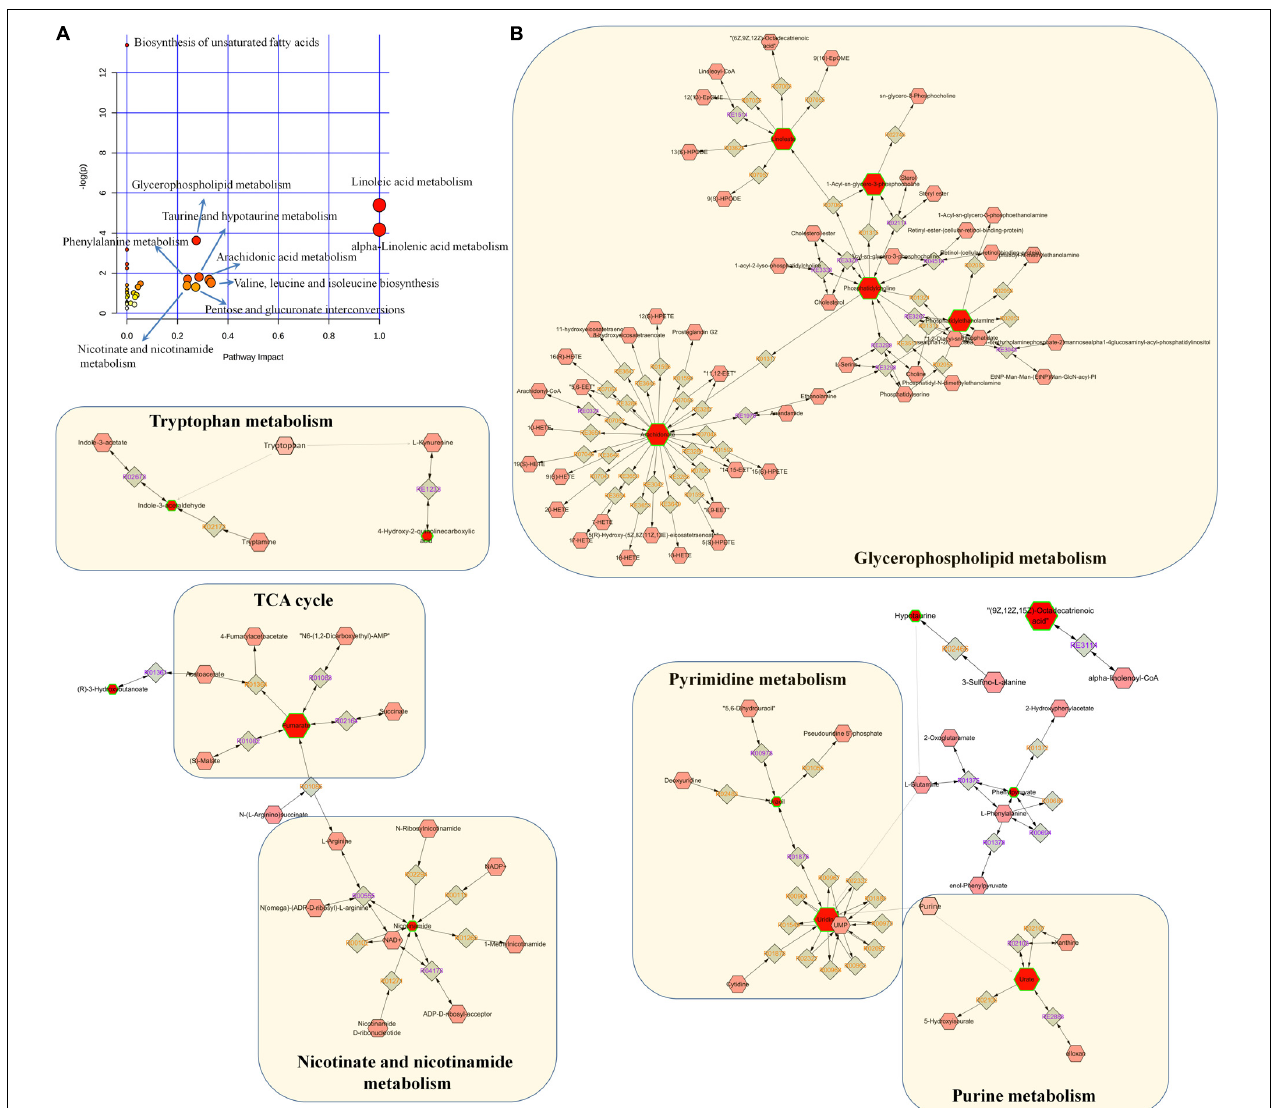
FIGURE 6 | Pathway analysis of the differential metabolites. (A) Pathway analysis of 40 differential metabolites. The size and color of each circle was based on pathway impact value and p -value, respectively. (B) Metabolic pathways were visualized by means of cytoscape software. The differential metabolites in our study were represented by red hexagons. Hexagons with green lines mean that the alteration of the biomarkers in CKD had statistical significance. The size of hexagons indicated the FC of the corresponding metabolite in CKD in relative to controls. In addition, pink hexagons indicated metabolites participating in the metabolic pathway but not been detected in our study. Diamonds mean that the metabolites convert to the products by the